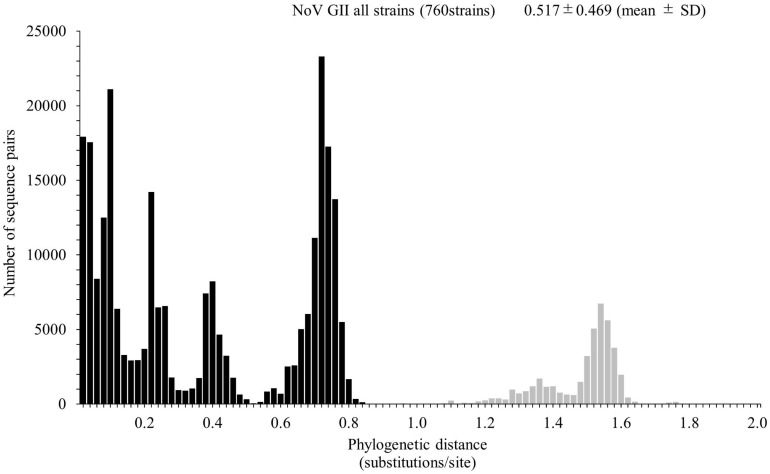
Distribution of phylogenetic distances of GII strains. The phylogenetic distance among NoV GII strains was calculated from the maximum likelihood (ML) tree constructed by the ML method. The y-axis represents the number of sequence pairs corresponding to each distance, and the x-axis shows the phylogenetic distance (substitutions/site). The distribution of phylogenetic distance for≥0.9 substitutions/site is shown in gray. The numbers on the histograms indicate the mean ± SD of the phylogenetic distance for GII strains.